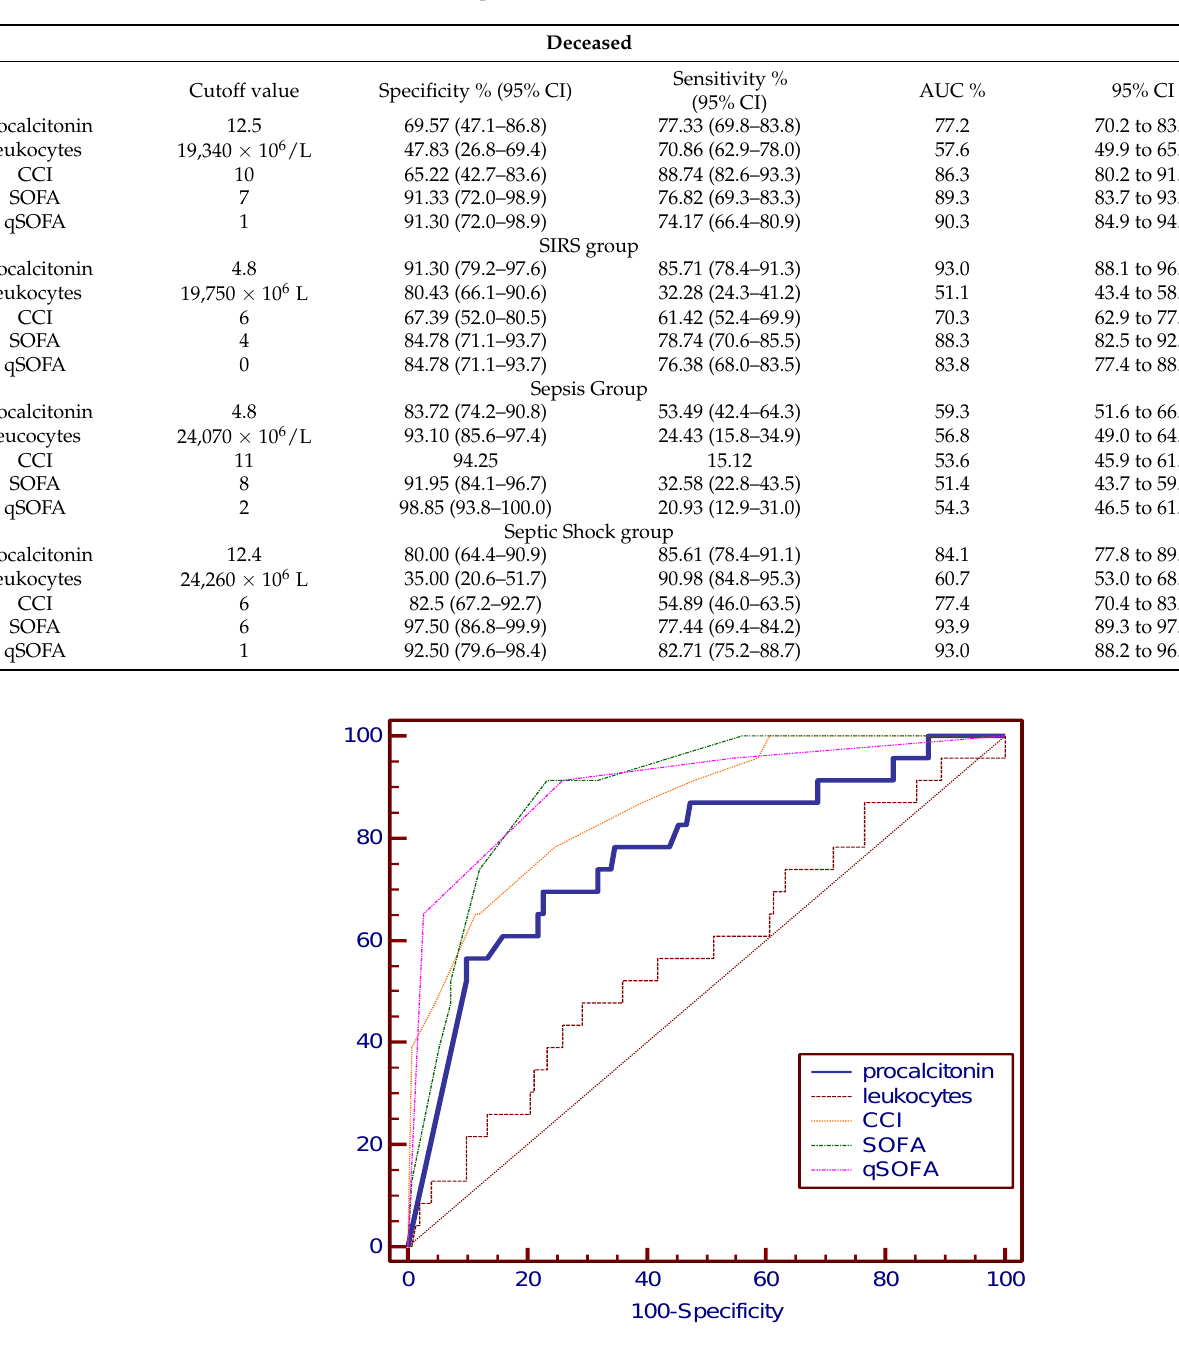
Table 2. Pairwise comparison of ROC curve.